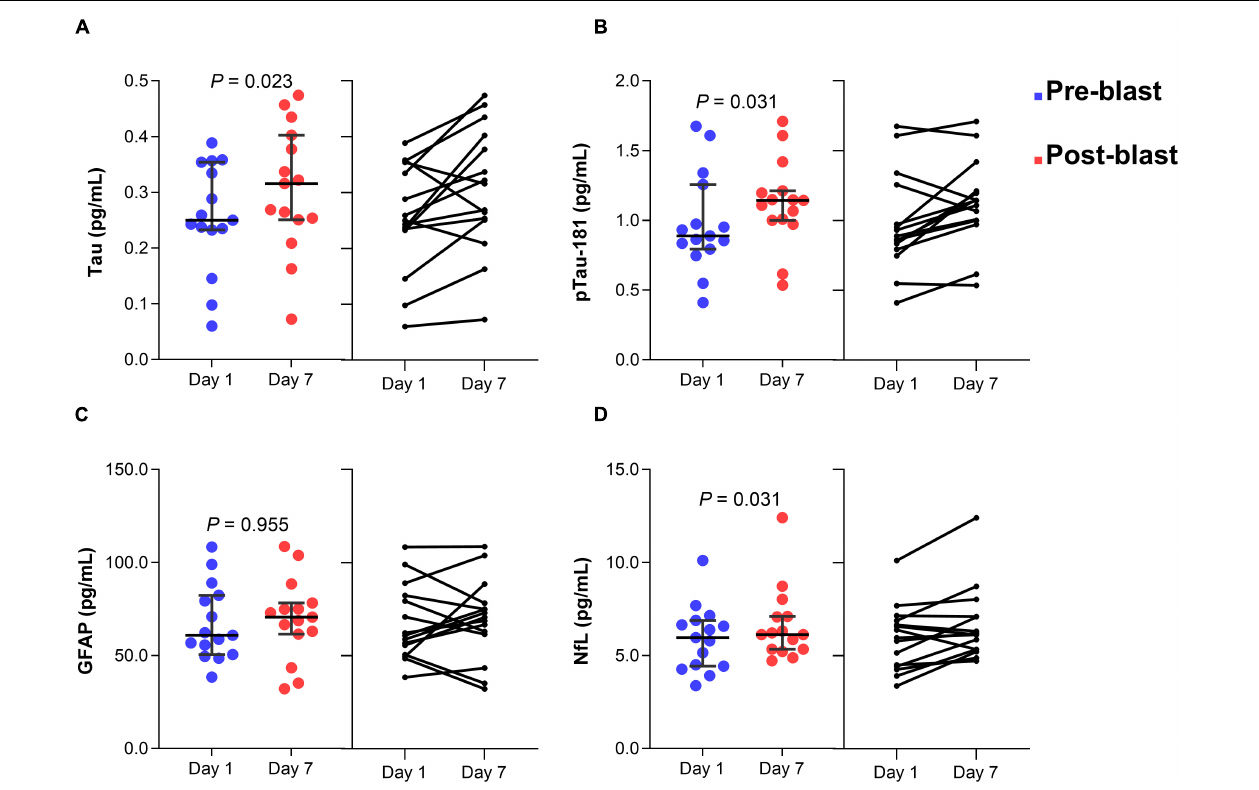
FIGURE 3 | Dot plots of serum tau (A) , p-tau181 (B) , GFAP (C) , and NfL (D) concentration before and after blast exposure at day 7. The horizontal line in each box represents the median, with the error bars representing the interquartile range. Wilcoxon signed-rank tests were used to analyze the differences before and after blast exposure p-tau181, phosphorylated tau-181; GFAP, glial fibrillary acidic protein; NfL, neurofilament light